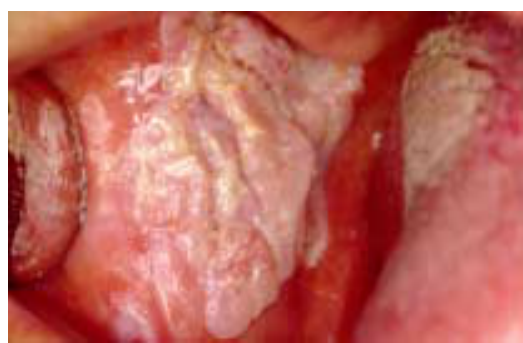
Fig. 8. Clinical view of a verrucous leukoplakia of the sinister pouch from patient D at his first visit in our clinic. This figure can be viewed on http://www.esacp.org/acp/2003/25-4/remmerbach.htm.